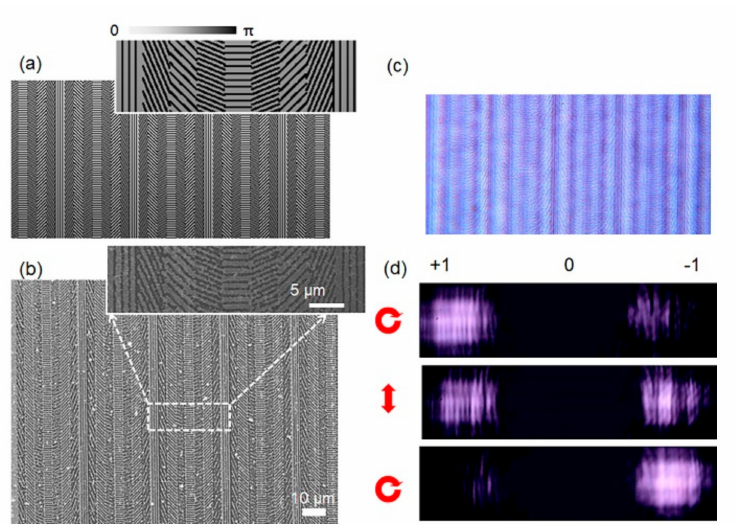
Figure 3. Geometric phase blazed grating. ( a ) Schematic diagram of a geometric phase served as a blazed grating; ( b ) SEM image of the fabricated grating; ( c ) optical microscope image of grating. Dark stripes in these images correspond to locations where the optic axis is aligned parallel or orthogonal to one of the polarizers; ( d ) measured di ff raction patterns from the geometric phase under illumination with right circular polarization (top), linear polarization (middle) and left circular polarization